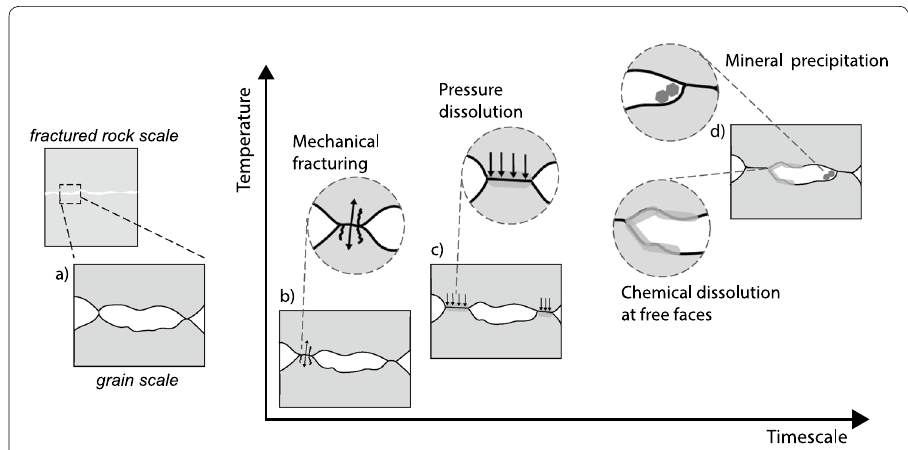
Fig. 1 Potential processes and their timescales. Illustration of potential thermal effects on a single fracture under low to moderate temperatures. a Original fracture, at the fractured rock scale and at the grain scale; b over short timescales, highly localized thermal stresses cause mechanical deformation/failure of the propping asperities; c over relatively short timescales, pressure dissolution of asperities may occur; d over longer timescales, and triggered by higher temperatures, mineral dissolution of the free faces along the fracture wall and possibly mineral precipitation at open fracture spaces may